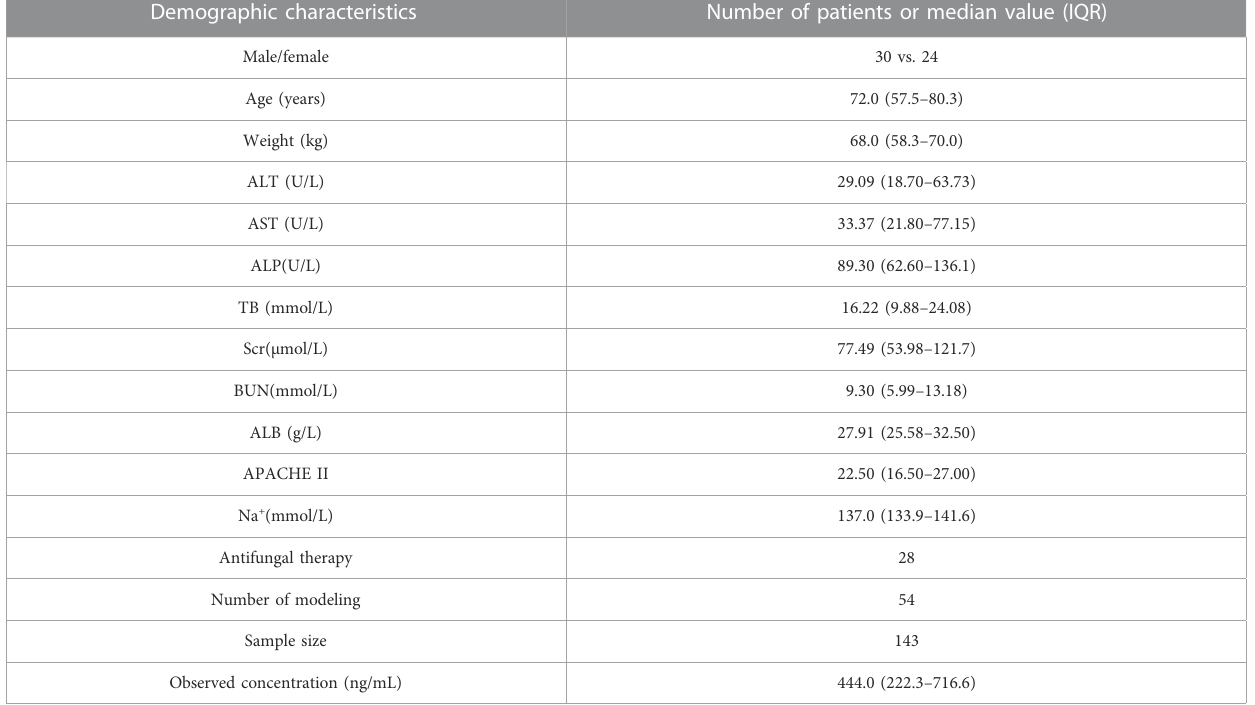
TABLE 1 Demographic characteristics and clinical data of ICU patients.